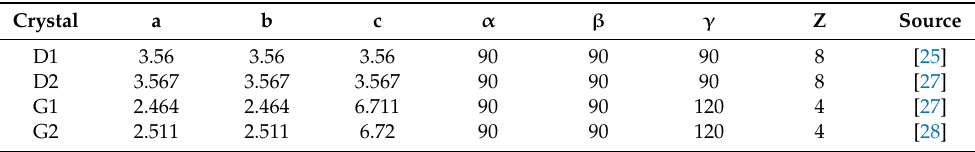
Table 2. Unit cell parameters of diamond and graphite.